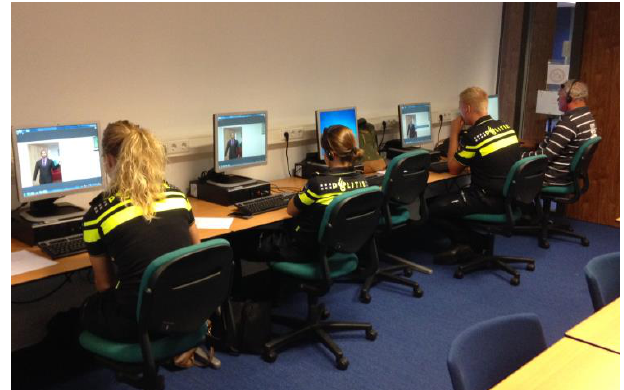
Figure 2. Impression of the pilot experiment.